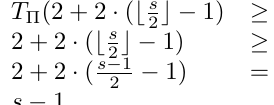
. Other randoms have been grayed out to avoid crowding the j